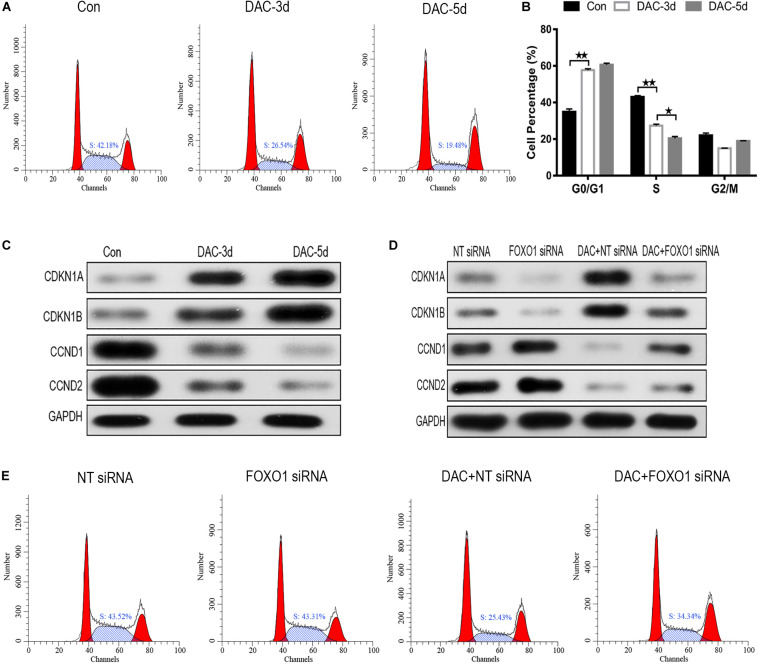
Decitabine induces cell cycle arrest in MDS-L cells. Annexin-V-FITC/PI assay showed that DAC treatment could decrease cells in S phase and arrest MDS-L cells in G0/G1 and G2/M phases (A,B). Western blot found that CDKN1A and CDKN1B in MDS-L cells increased with CCND1 and CCND2 protein decreasing after DAC treatment (C). FOXO1 silencing had no obviously influence on CDKN1B and CCND1, but decreased the expression of CDKN1A and CCND2 that was observed following DAC treatment (D). DAC-induced reduction of MDS-L cells in the S phase was significantly attenuated after silencing FOXO1 (E). **Student’s t-test P < 0.01 and *P < 0.05.